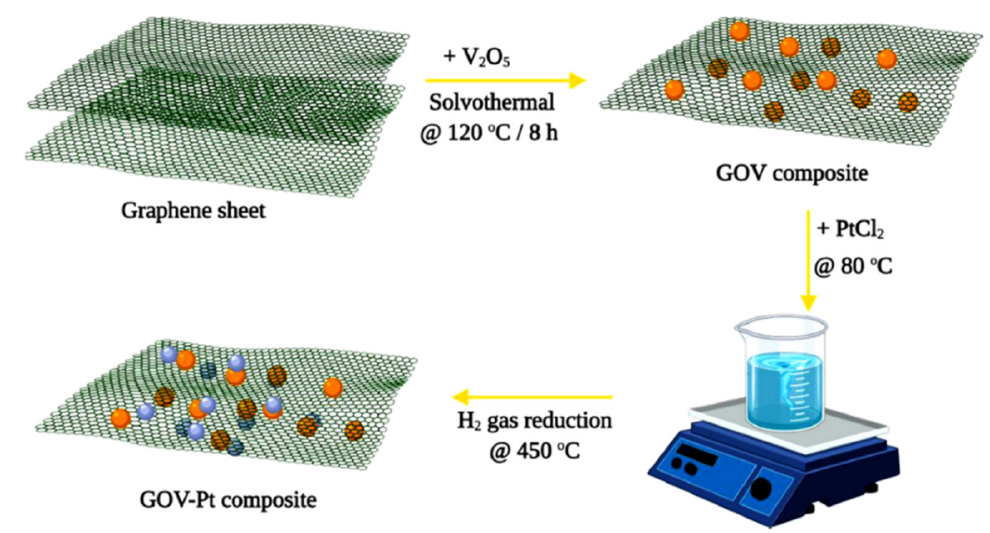
Figure 15. The schematic illustration of a graphene oxide/V 2 O 5 /Pt ternary composite photocatalyst synthesis [170].